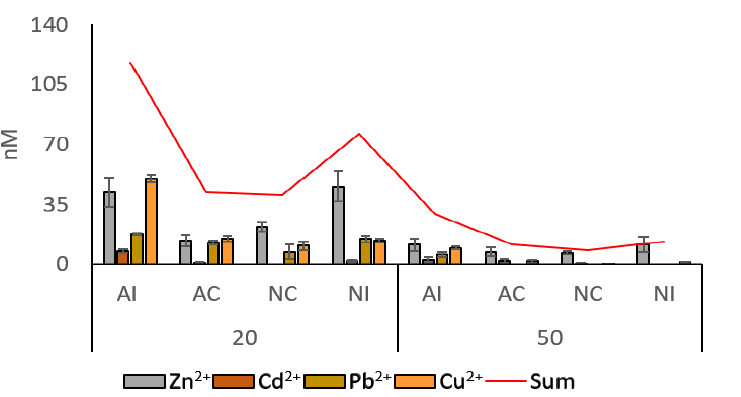
Figure 2. Heavy metals concentration (nM) among stations; “Sum” indicates the sum of all detected metals in each station.